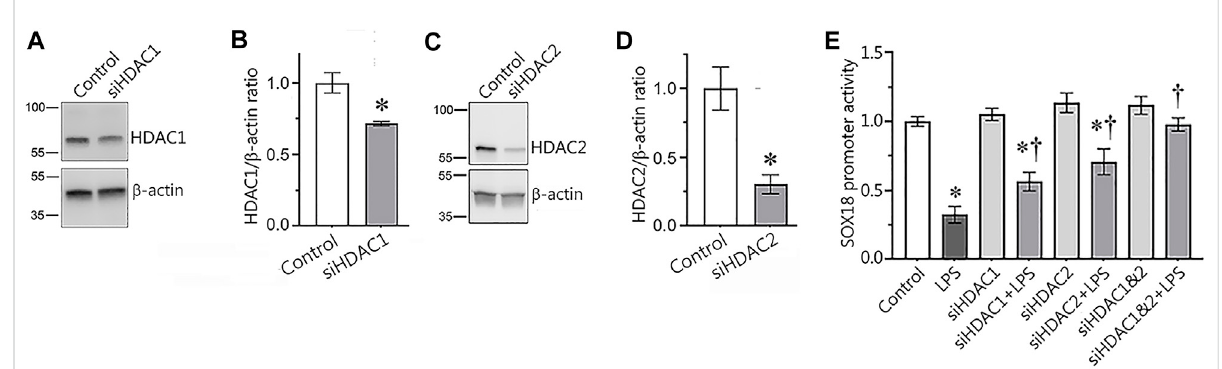
FIGURE 4 siRNA-mediated depletion of HDAC1 or HDAC2 attenuates the LPS-induced repression of the Sox18 promoter in cultured human lung microvascular endothelial cells. HLMVEC were transfected with scrambled-, HDAC1- (A,B) , or HDAC2- (C,D) siRNAs and Western blot analysis was usedtocon fi rmmRNAdepletion.HDAC1orHDAC2depletionattenuatedtheLPS-mediatedrepressionofaSOX18-luciferaseconstruct (E) .Dataare mean ± SEM, n = 3 (for immunoblots), n = 9 – 12 (for luciferase assay). * p < 0.05 vs . Control; † p < 0.05 vs . LPS alone.